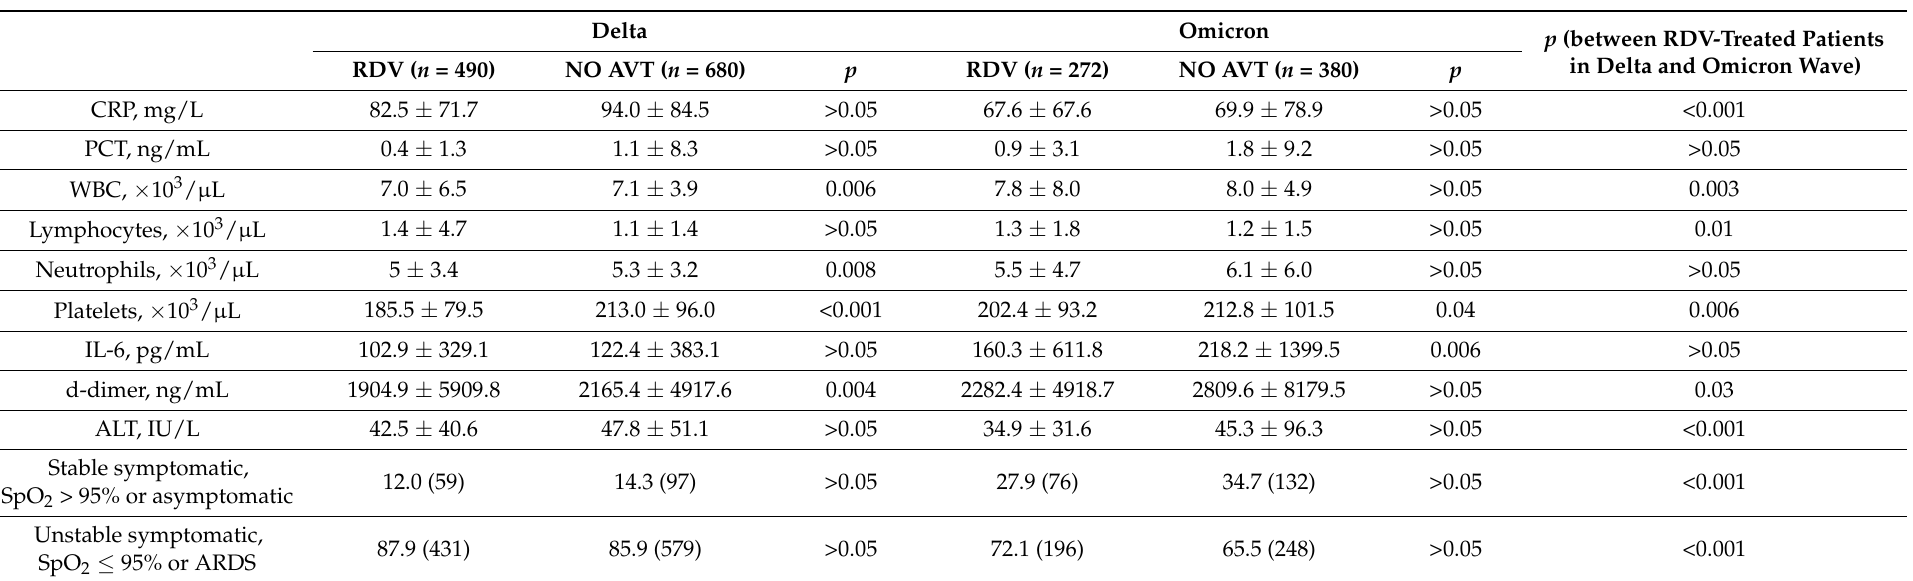
Baseline clinical status and laboratory parameters (mean ± SD) of patients hospitalized during Delta and Omicron waves with regard to remdesivir (RDV)